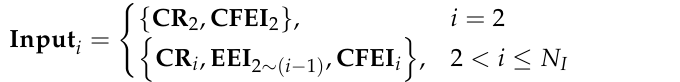
and h = H represent 32 32